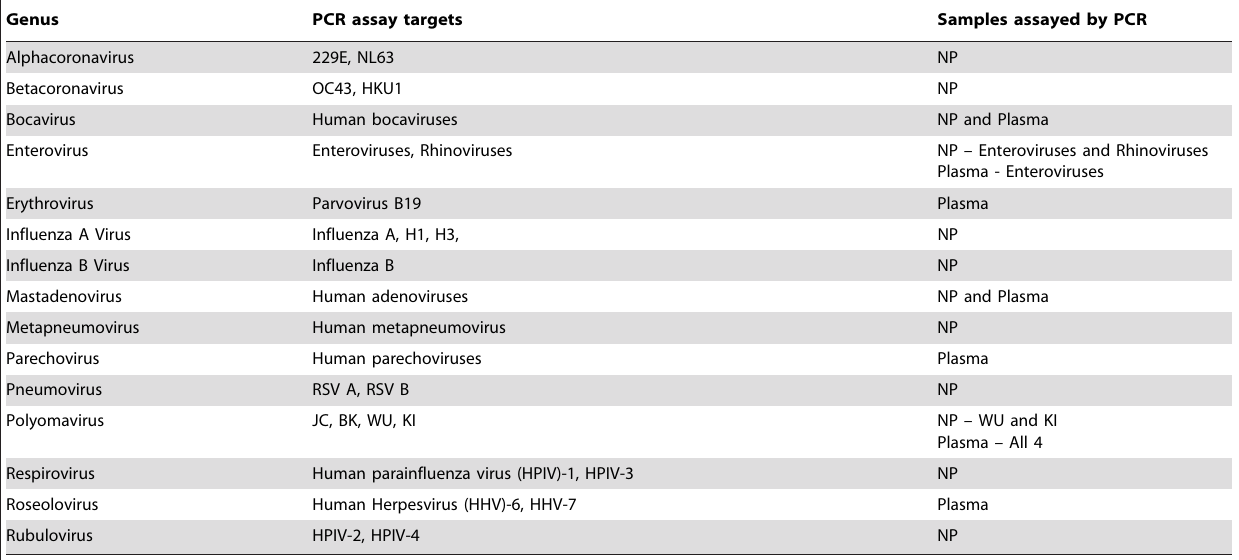
Table 3. Virus genera screened by PCR.